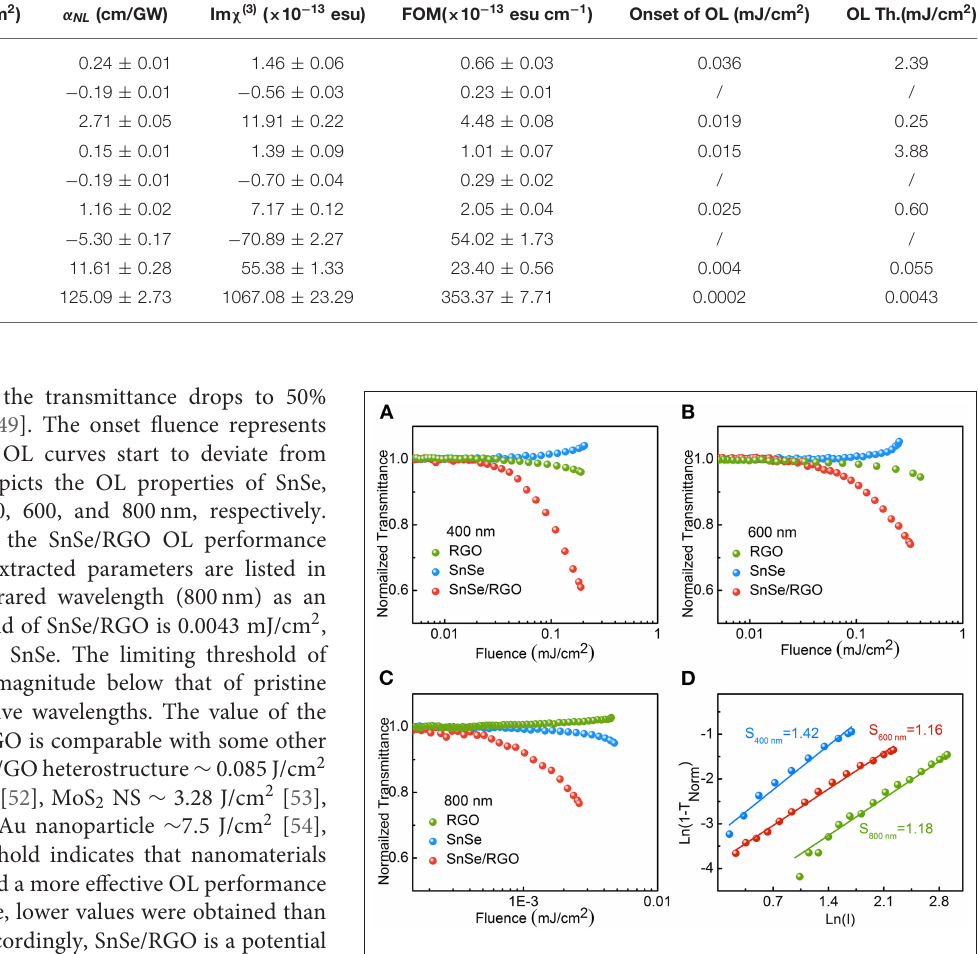
FIGURE 3 | (A–C) Normalized transmittance vs. optical energy density; (D) Plots of ln(1—T Norm ) vs. ln(I) to determine the non-linear order of SnSe/RGO.